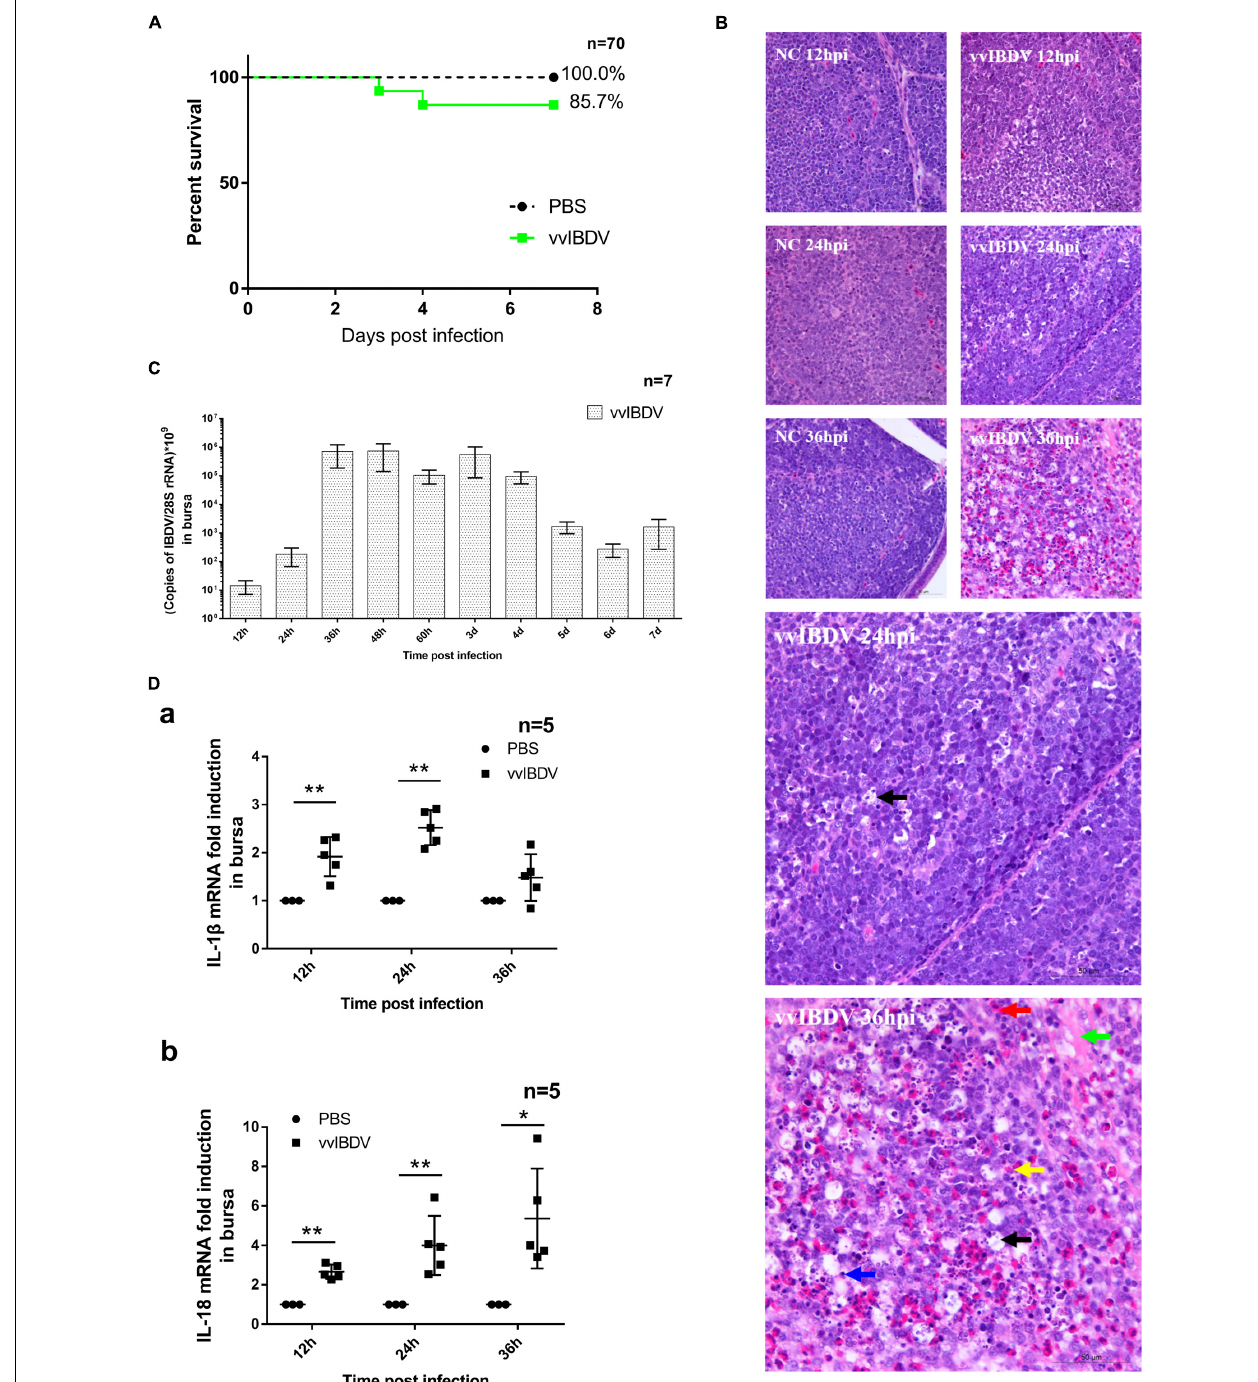
FIGURE 1 | Very virulent infectious bursal disease virus (vvIBDV) infection led to inflammation of the bursa and mortality in specific-pathogen-free (SPF) chickens. Three-week-old SPF chickens were infected with 1 × 10 2 ELD 50 vvIBDV or were mock infected with phosphate-buffered saline (PBS) alone. The chickens were sacrificed at the following time points: 12 h, 24 h, 36 h, 48 h, 60 h, 3 days, 4 days, 5 days, 6 days, and 7 days. (A) Survival curves were based on the mortality recorded at each time point. (B) For histopathological analysis, bursal samples from vvIBDV-infected chickens stained with H&E were examined using light microscopy. In the vvIBDV infection group, macrophage proliferation (black arrow) was observed in individual follicles at 24 h.p.i. as well as slight hemorrhage (red arrow), depletion of lymphocytes (blue arrow), lesions in the bursal follicles (green arrow), proliferation of reticulum cells and macrophages (black arrow), and infiltration of inflammatory cells (yellow arrow) at 36 h.p.i. (C) VvIBDV replication in bursa samples. (D) The transcription levels of host inflammatory cytokines IL-1 β and IL-18 were measured by quantitative polymerase chain reaction (qPCR). ∗ P < 0.05 and ∗∗ P < 0.01 compared with control groups.